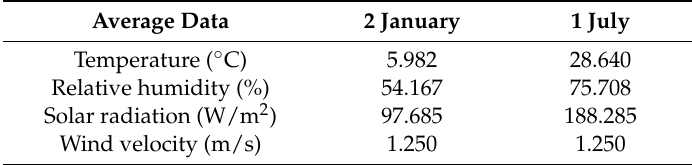
Table 1. The typical meteorological day in winter and summer for